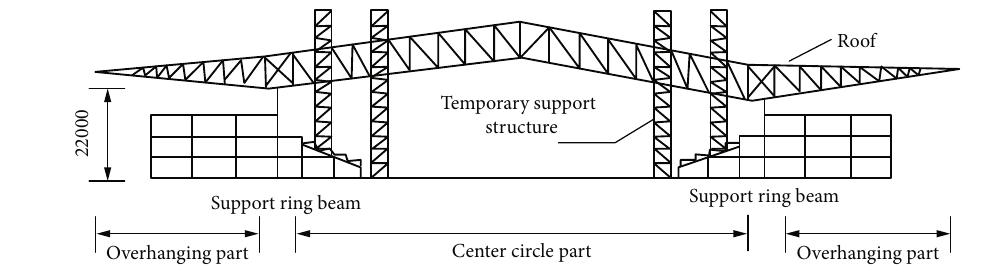
Figure 4: Long-span steel structure roof model. Table 3: Initial values of vibration and set of control objectives.